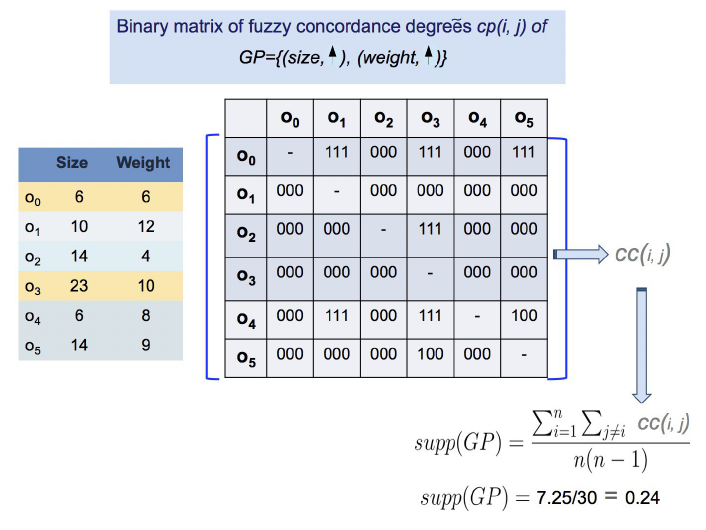
Figure 4. Illustration of the binary matrix of fuzzy concordance degrees with a precision of three